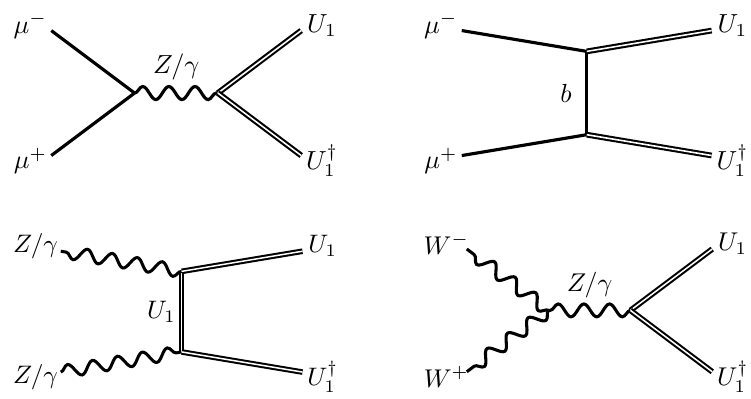
Figure 1 . Leading diagrams giving rise to LQ pair production at MuC. The top row shows direct pair production from muon collisions, while the bottom row shows possible contributions from VBF- like diagrams, where the gauge bosons are to be understood as arising collinear radiation from the radiation beam and the remanant particle is unobserved. (See section 3.2 for more details.) Except for the top-right diagram, all the other ones only depend on the electroweak gauge couplings.